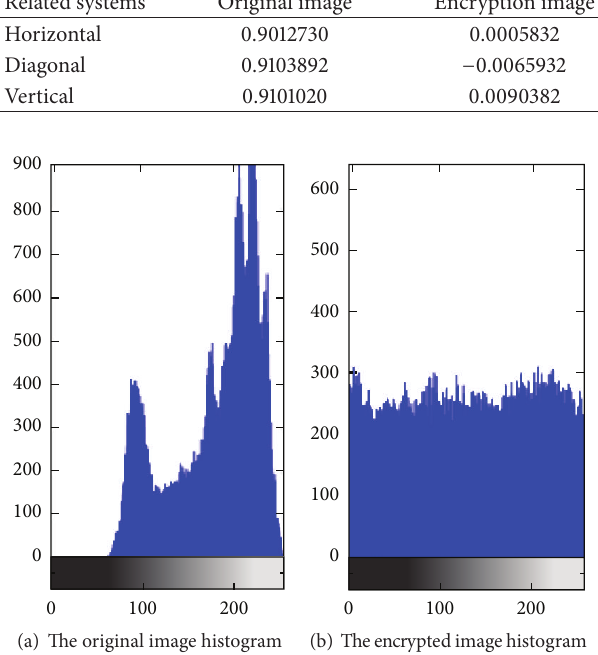
Figure 12: The histogram comparison of R component.